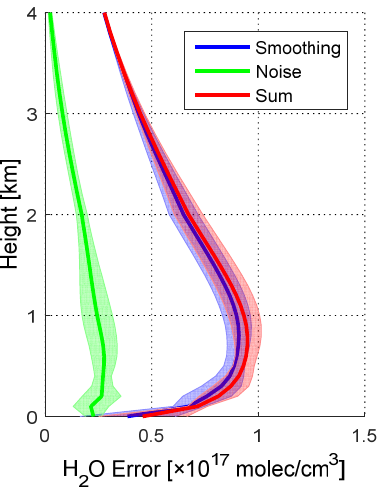
Figure 10. Averaged vertical distributions of noise error (green), smoothing error (blue), and the sum thereof (red) during the measurement period.